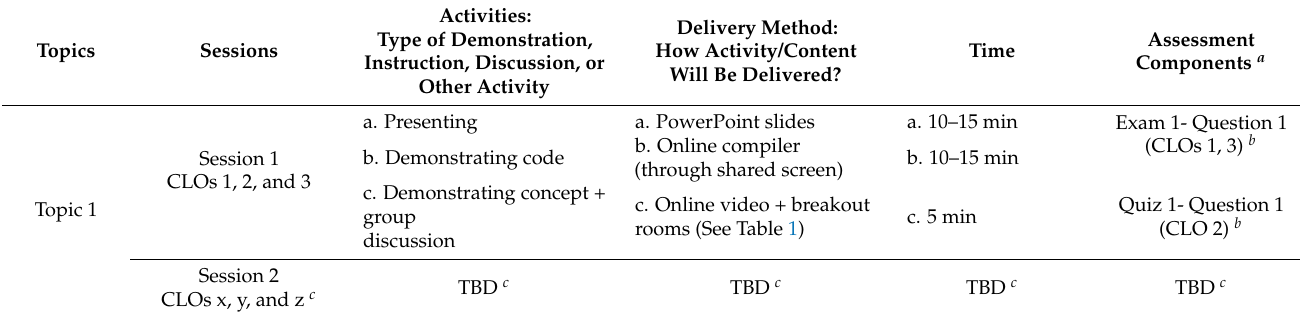
Table 2. High-level outcome-based lesson